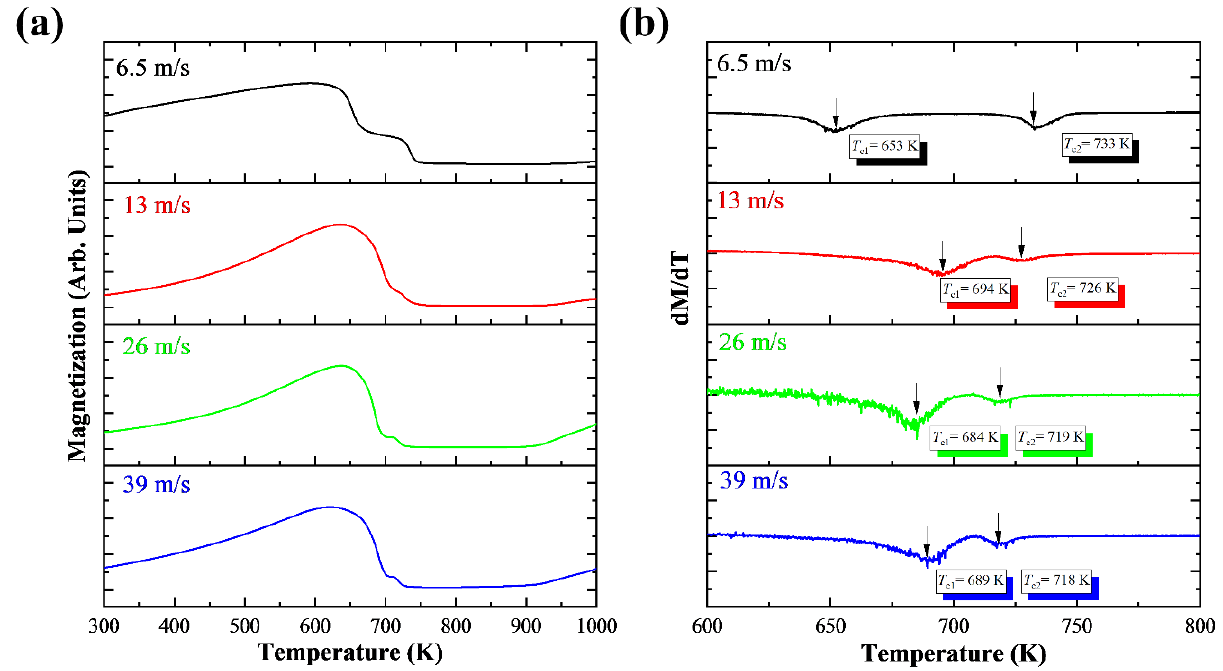
Figure 3. Temperature dependences of ( a ) normalized magnetizations and ( b ) temperature derivative of magnetization ( d M/ d T) curves of the Sm(Fe 0.8 Co 0.2 ) 10 Si 2 ribbons with different wheel speeds under an applied magnetic field of 0.02 T.